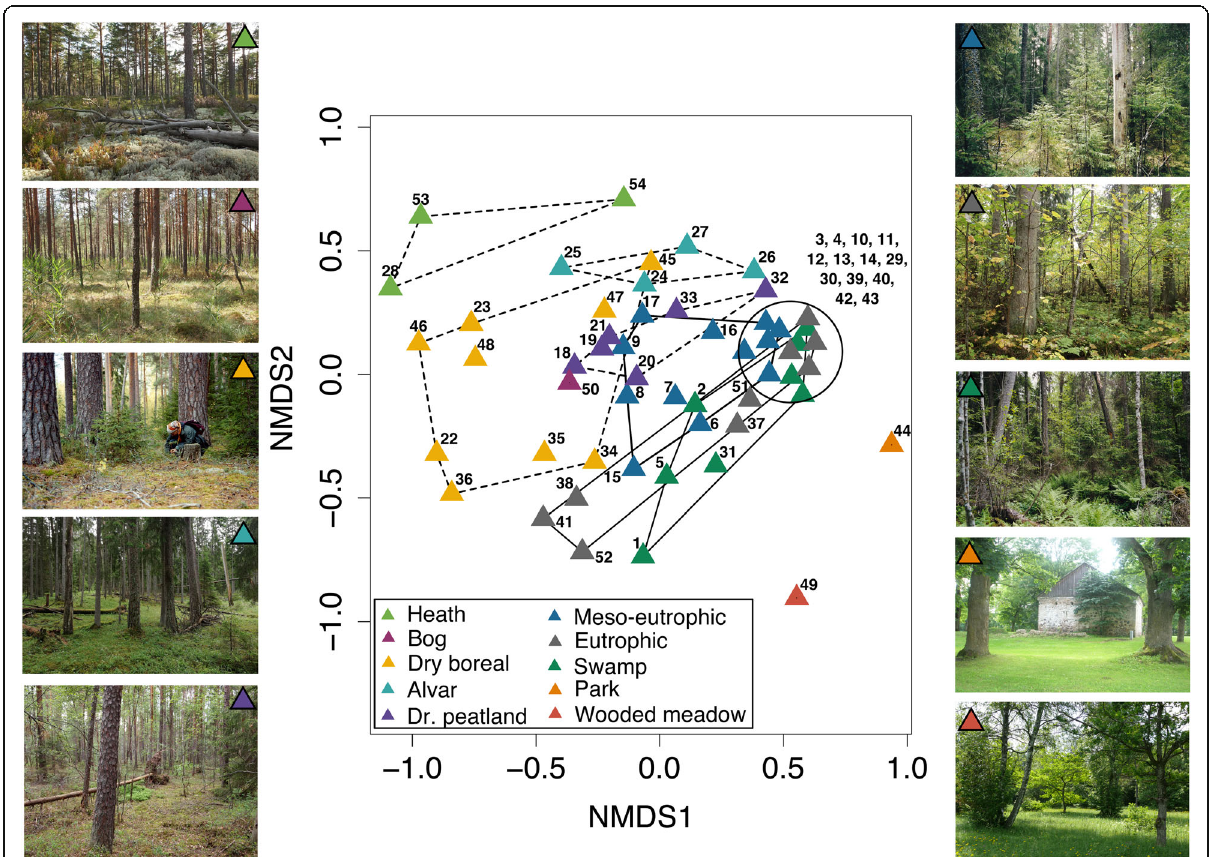
Fig. 2 Non-metric multidimensional scaling (NMDS) ordination diagram of polypore assemblages in 54 site-type group × tree species × age combinations (points; the number codes explained in Additional file 1). The two-dimensional solution with the final stress value of 0.166 is shown. The symbols denote woodland types; photo credits: E. Lõhmus, P. Lõhmus, A. Palo. Note the three woodland types represented by a single pooled species list: parks (44), wooded meadows (49) and bog forests